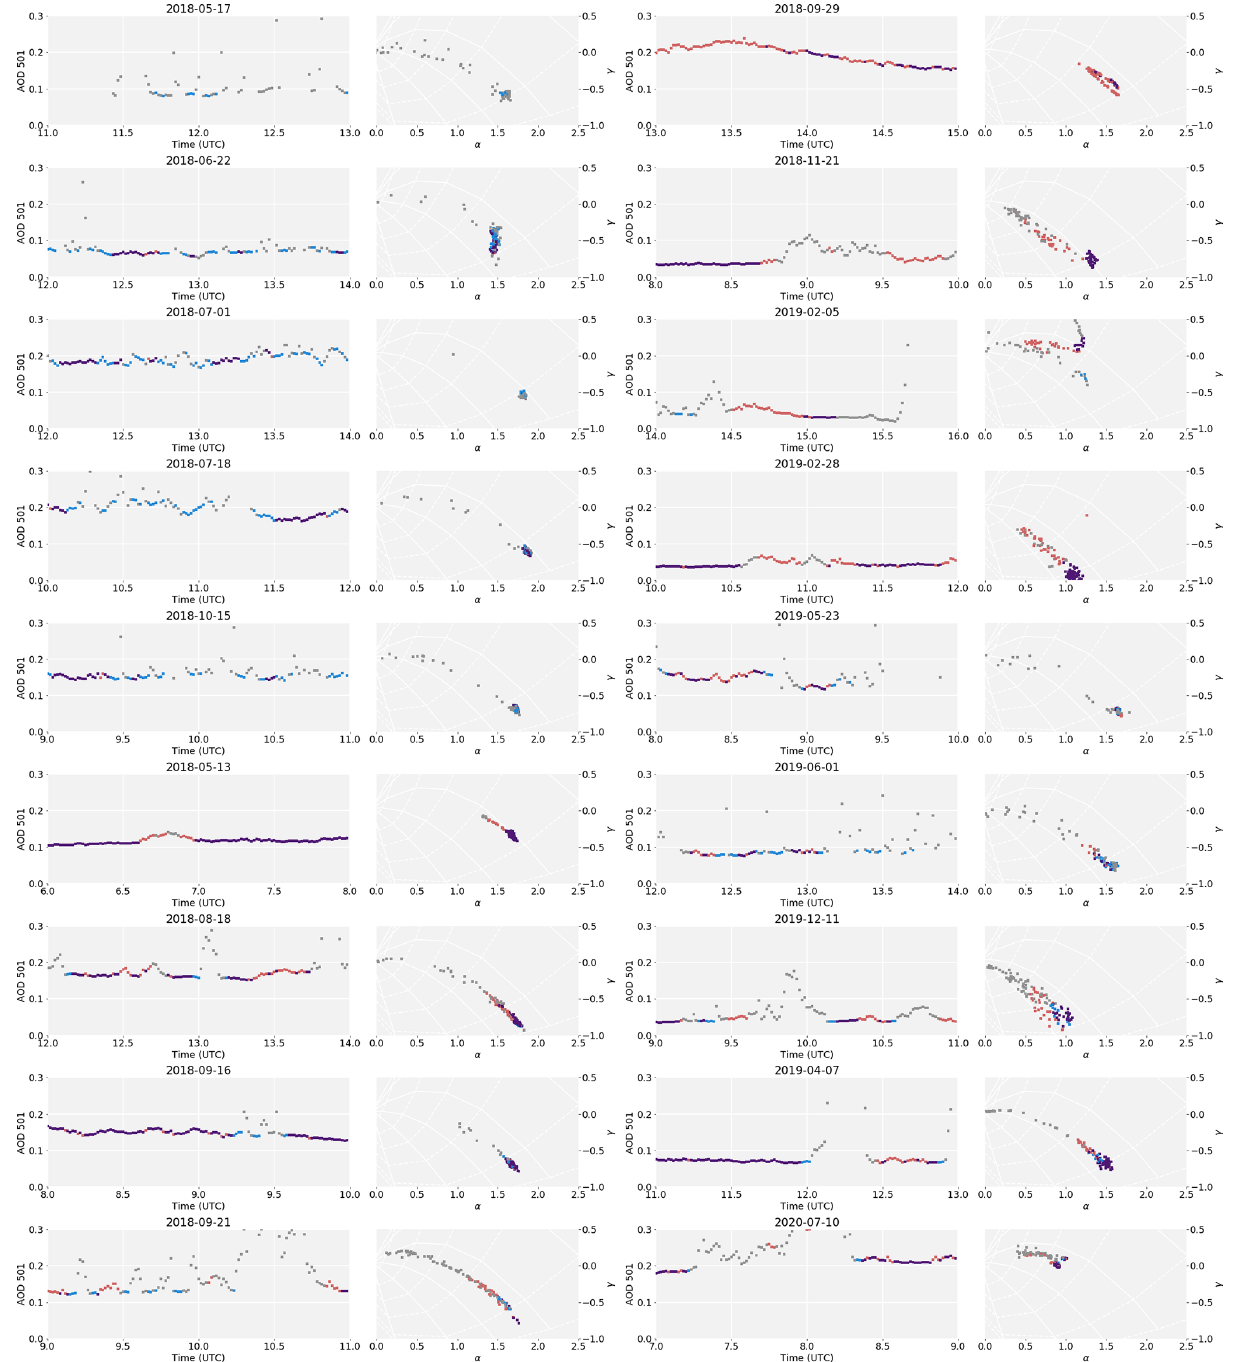
Figure A1. The 2h excerpts from selected days (in addition to Fig. 4). The first five examples highlight cases where Clustering flags much less than Multiplet; the others show the performance in the presence of thin clouds. Both categories are ordered by